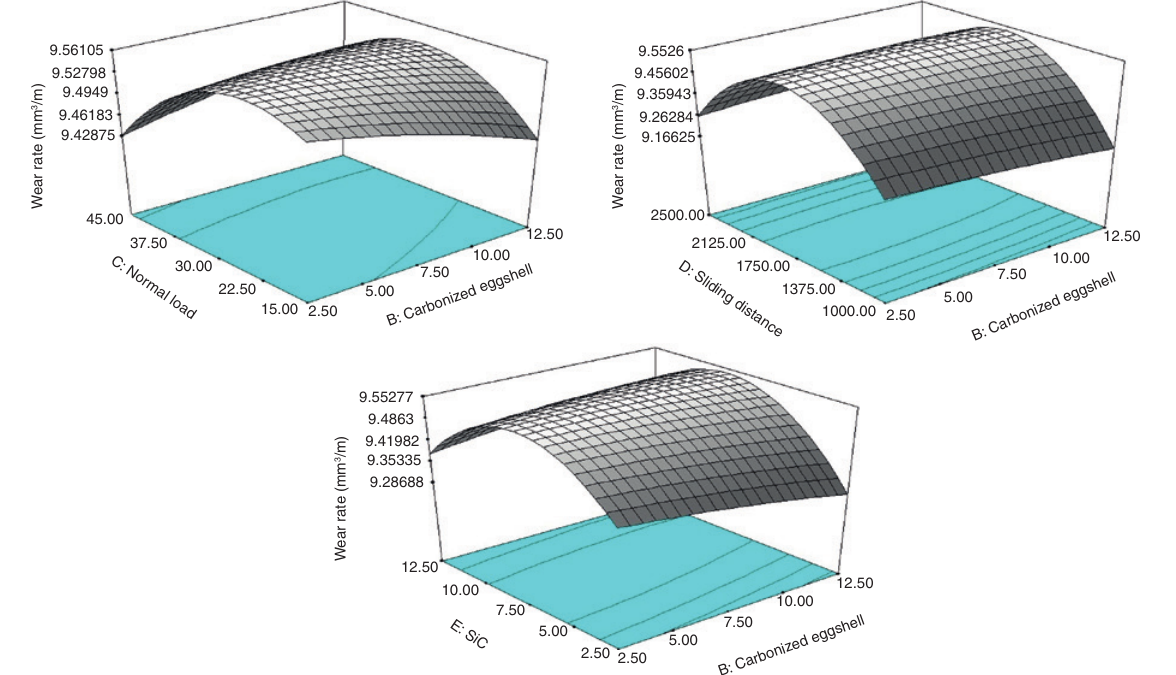
Figure 12: Interactions of carbonized eggshell wt.% with normal load, sliding distance, and SiC wt.% to reduce wear rate.